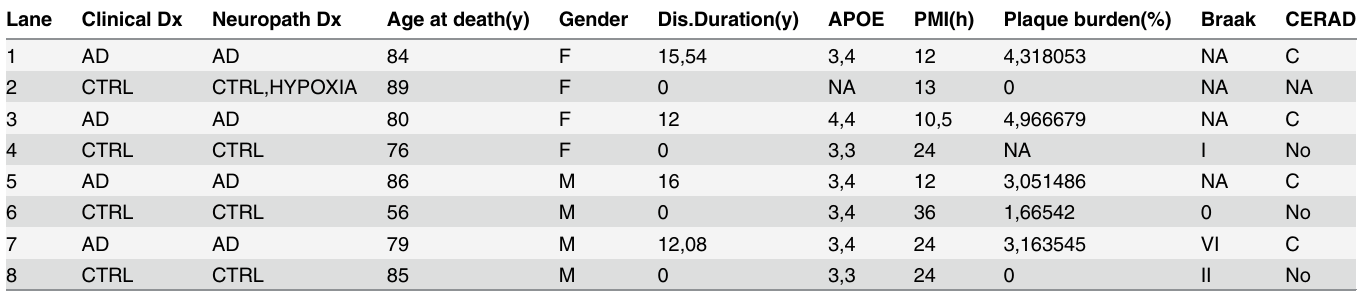
chemiluminescence. Clinical diagnoses of the patients of which brain tissue samples were used for Western blot analysis are shown in Table 1. RNA Extraction, cDNA Synthesis, and Quantitative PCR Total RNA was isolated by using the mirVana isolation kit (Ambion) following the manufac- turer's instructions. RNA concentration was measured with the NanoDrop (Peqlab) device.